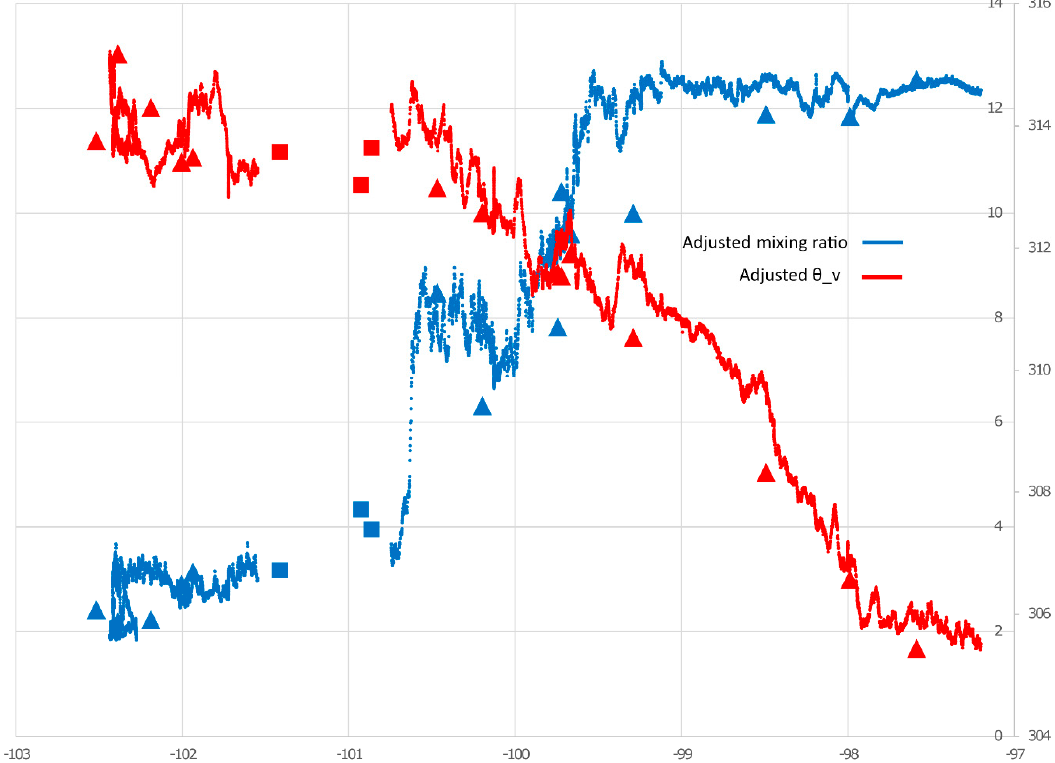
Figure 12. Mobile mixing ratio (blue; g/kg) and 𝜃 𝑣 (red; K) vs longitude, temporally adjusted to 2135 UTC on 9 April 2017. Station data used in temporal adjustment are shown by triangles, and in data gap by squares.